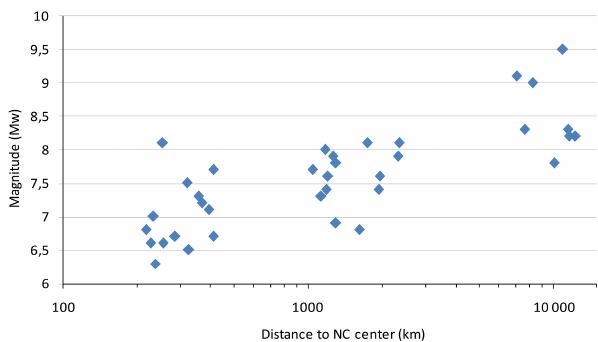
Figure 13. Graphic representation of the new catalogue showing earthquake’s magnitude ( M w ) as functions of distance between epi- center and New Caledonia